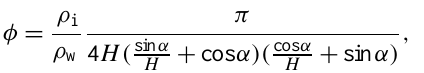
Fig. 5. Histogram of the solid fraction of un-consolidated grease ice for all experiments with waves and with current and wind deter- mined with (a) the calorimeter method and (b) the volume method.